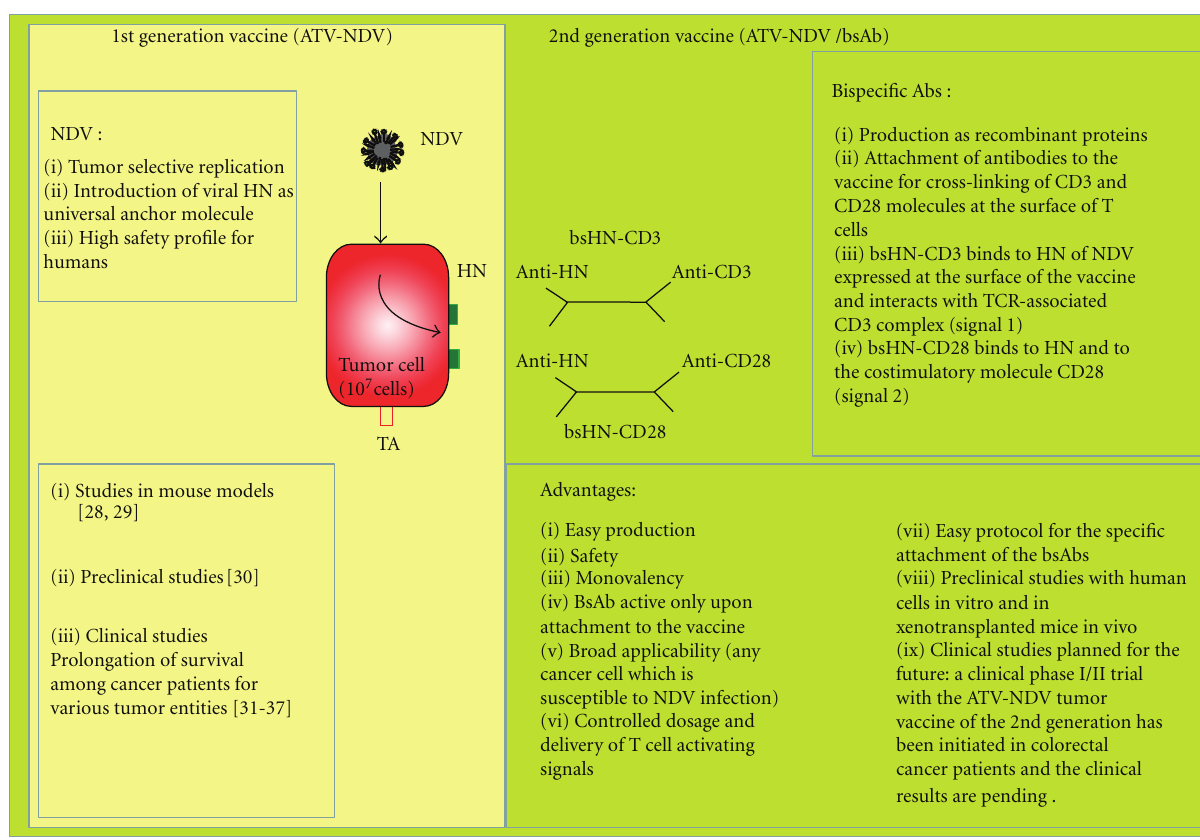
Figure 1: Principles of the NDV-based tumor vaccine of the first and second generation and status of the art (for more details, see the main